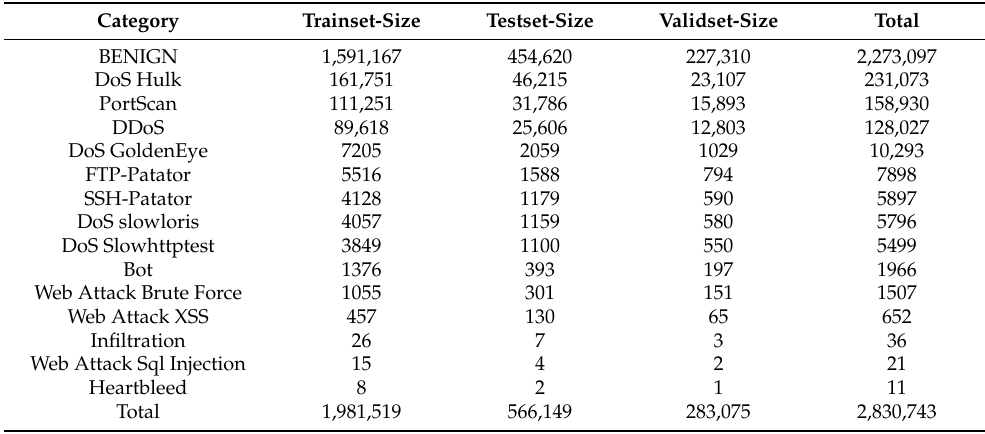
Table 3. CICIDS2017 Dataset